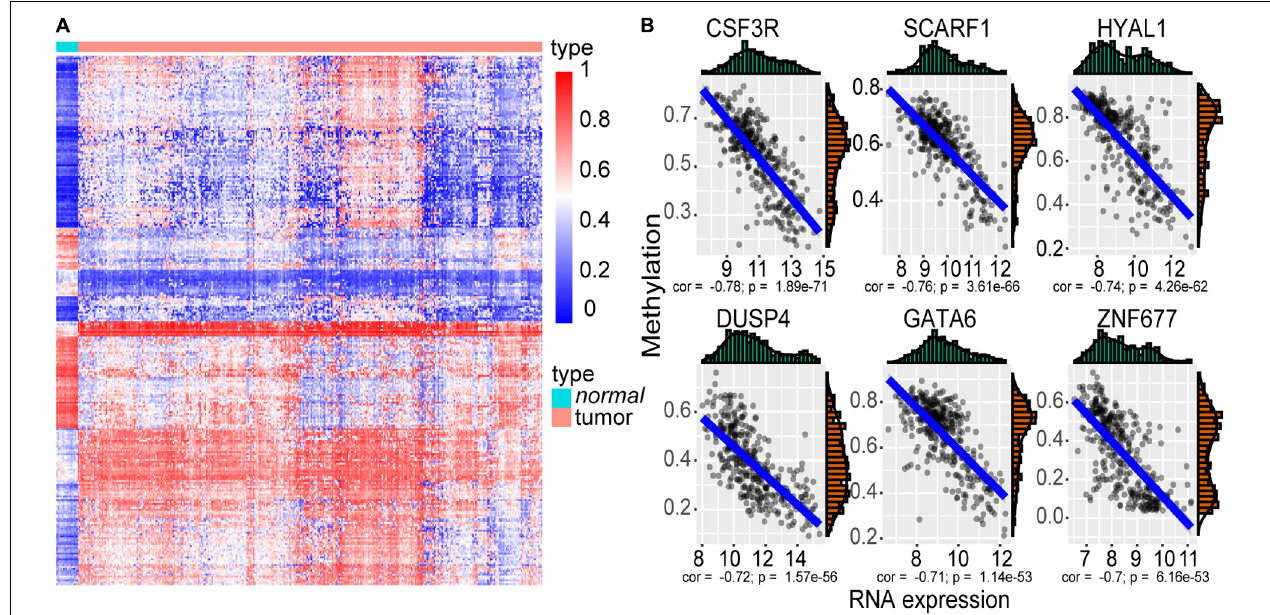
FIGURE 2 | The methylation driver genes. (A) Heatmap of the 277 methylation driver genes. The color from blue to red indicates the trend from hypomethylation to hypermethylation. (B) Scatter plot of the top six negatively correlated genes. The x -axis represents the RNA-seq expression value, and the y -axis represents the methylation beta